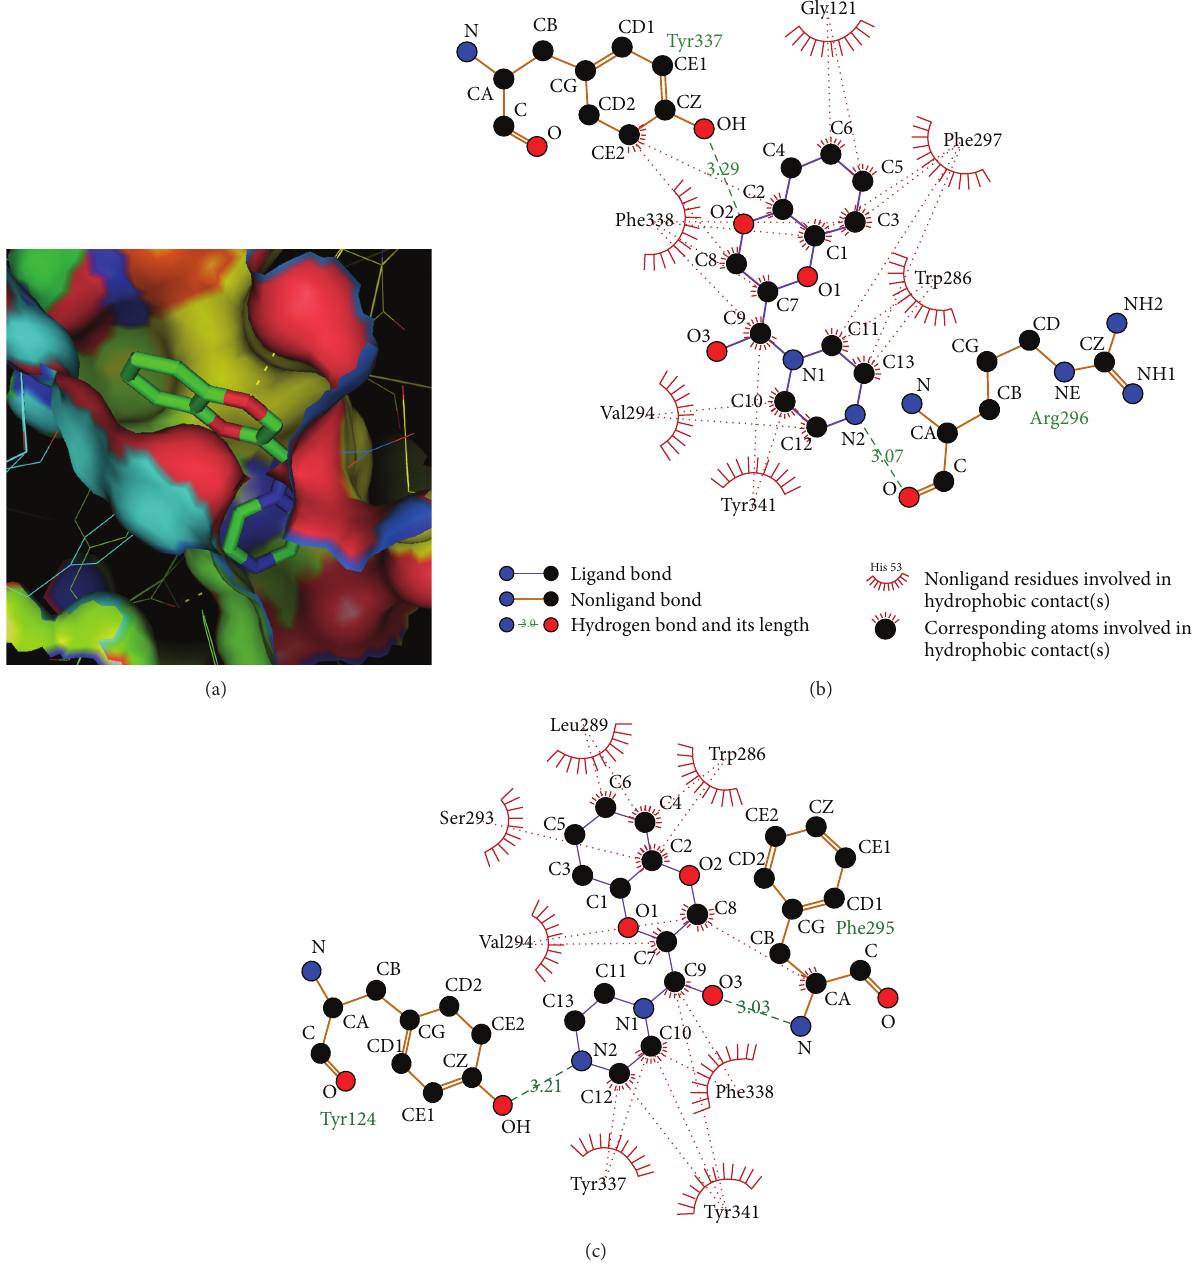
Figure 3: (a) Catalytic site docking of 1-(1,4-benzodioxane-2-carbonyl) piperazine (K)[Pymol view]. (b) Catalytic site docking of 1-(1,4- benzodioxane-2-carbonyl) piperazine (K). (c) Peripheral anionic site docking of 1-(1,4-benzodioxane-2-carbonyl) piperazine